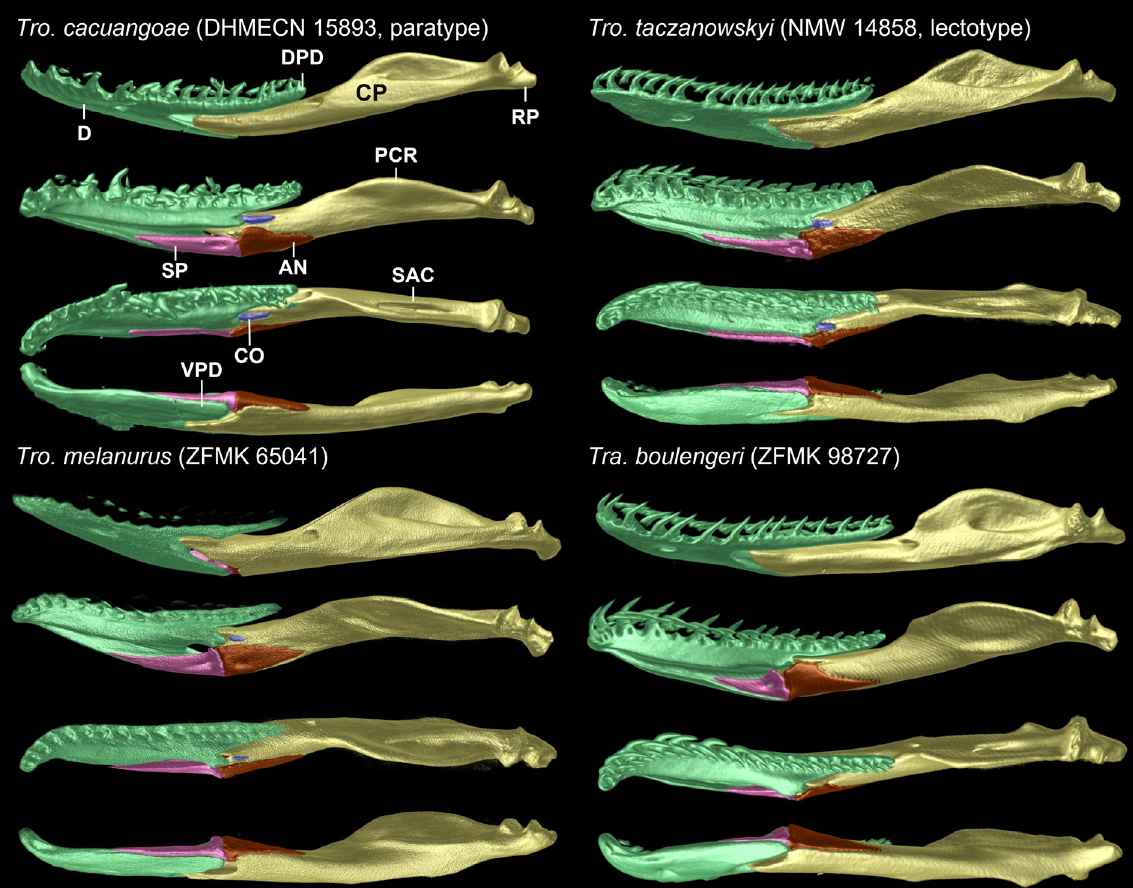
Fig. 13. Micro-CT images of the right mandibula of Tropidophis cacuangoae sp. nov., ♀ (DHMECN 15893, paratype), T. taczanowskyi (Steindachner, 1880) (NMW 14858, lectotype), T. melanurus